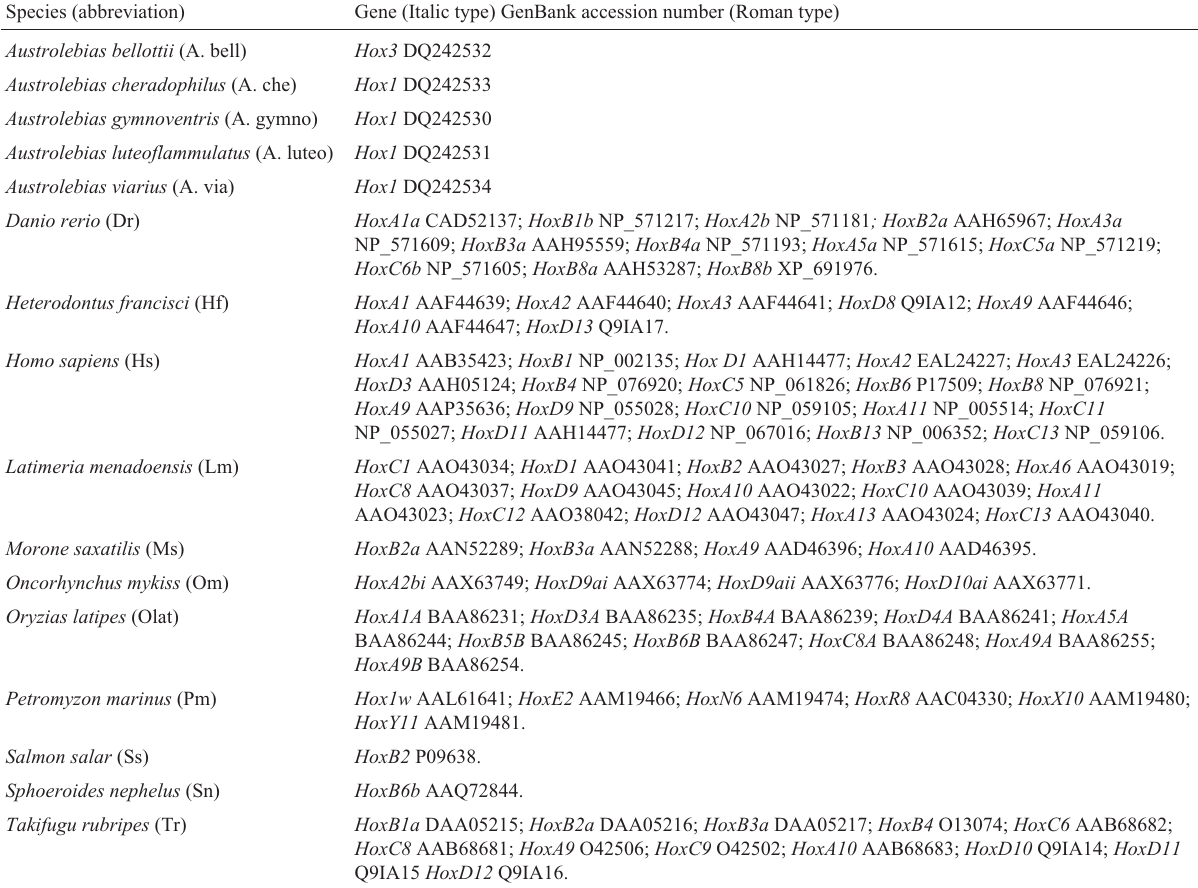
Table 2 - Abbreviations and GenBank accession numbers of species used in Figures 2 and